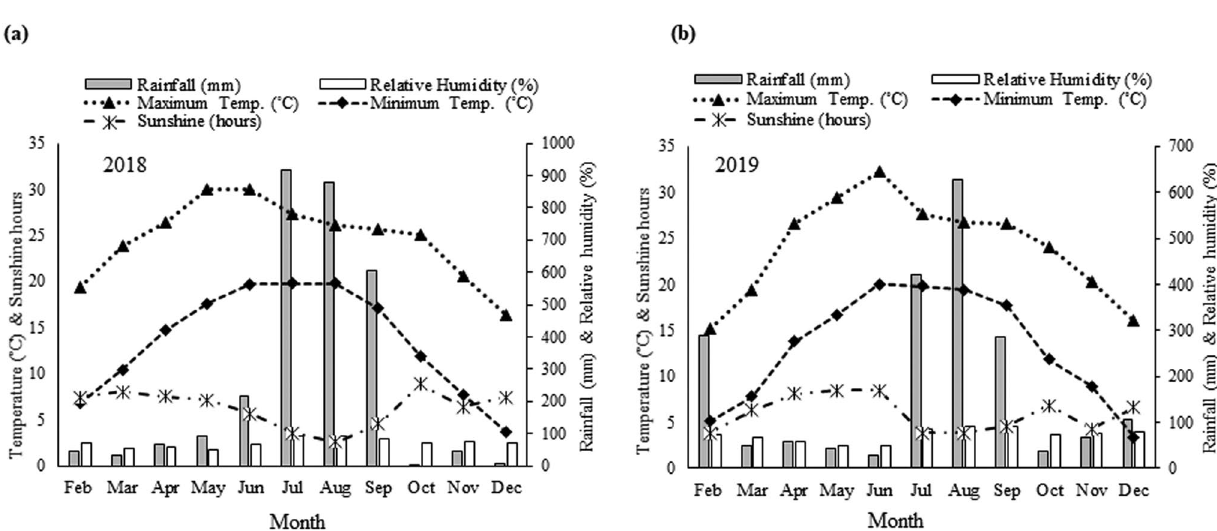
Figure 6. Monthly mean maximum and minimum temperatures (°C), relative humidity (RH%) rainfall (mm), and sunshine hours (SS) during the plantation and study seasons of 2018 (a) and 2019 (b)